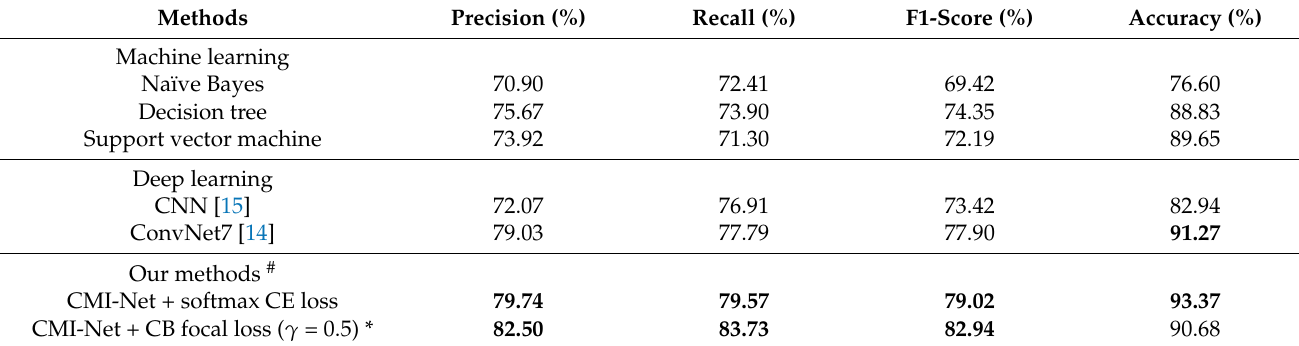
Table 1. Classification performance comparison with existing methods. The best two results for each metric are highlighted in